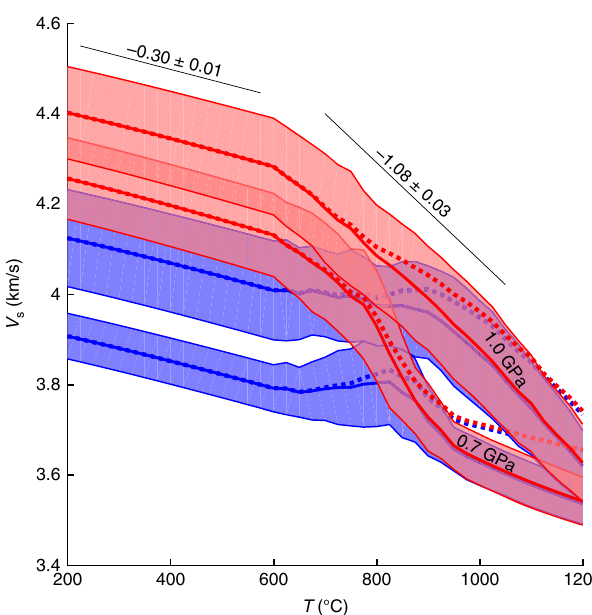
Fig. 5 Calibration of V s — temperature relationship for typical Cascadia basement rocks. Velocities are calculated for a suite of 16 reported major- element compositions for the Siletz-Crescent basaltic terranes 86,87 , which are likely basement for the Cascadia forearc 88 . Modal mineralogy is calculated for each sample ’ s major element composition via the free-energy minimization code Perple_X 89 at a range of pressures and temperatures, and parameters such as V s and density are calculated 90 . Because chemical equilibrium is unlikely at low temperatures, below 600 °C the modal compositions are fi xed to those at 600 °C (500 °C for when H 2 O is present). At high temperatures additional anelastic velocity reduction is incorporated by scaling gabbro to olivine anelasticity through their creep properties (see Methods). Red: water-free calculations; blue: calculations with 2 wt% H 2 O; thickness of swath includes one standard deviation of variation among the 16 samples. Dotted lines show results neglecting physical dispersion. Calculations shown at 0.7 and 1.0 GPa as labeled. Note change in slope, labeled, between − 0.30 ± 0.01 m/s/K at low temperatures where only mineral elasticity effects velocities, to − 1.08 ± 0.03 m/s/K for dry conditions at temperatures where petrologic and anelastic effects also contribute. In modeled compositions with 2 wt% H 2 O the effect is more complicated and the overall trend is midway between these